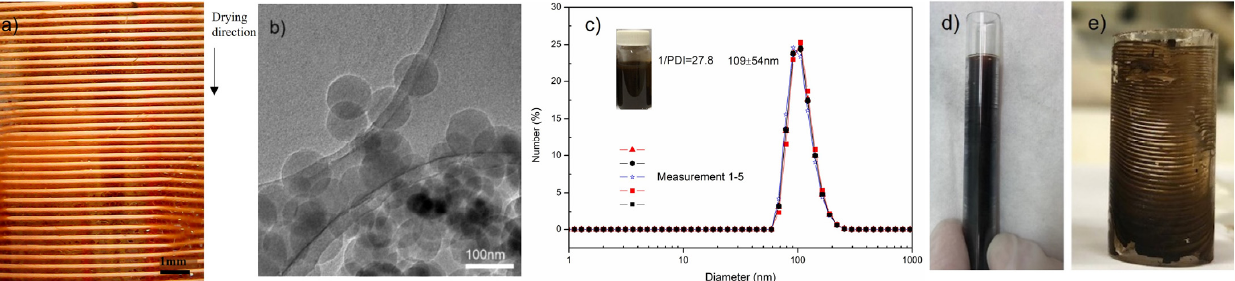
Figure 1. ( a ) An optical image of the lines that formed on evaporation of a colloidal dispersion of hydrochar CH3.63-NaOH in a glass vial; ( b ) TEM image of the hydrochar particles; ( c ) the monodispersity and number particle size distribution (with a confidence level of 95% for the deviation) of the standard dispersion of CH3.63, measured by dynamic light scattering; ( d ) a photo of a glass tube; and ( e ) an immersed glass cylinder with two open ends with rings formed both inside and outside due to the evaporation of CH3.63-SDS, individually. Table 1. Line patterns formed on substrates for colloidal dispersions during the evaporation of the dispersants (solvents).